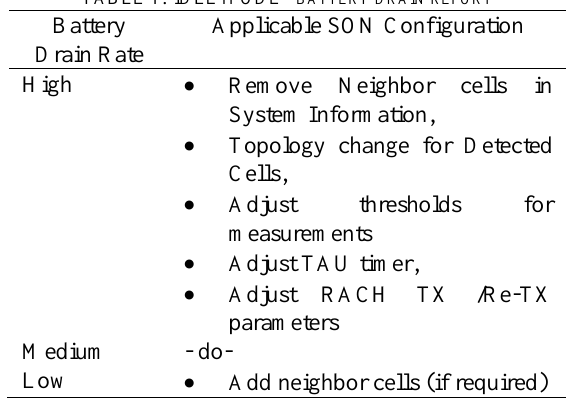
TABLE 1. IDLE MODE - BATTERY DRAIN REPORT Battery